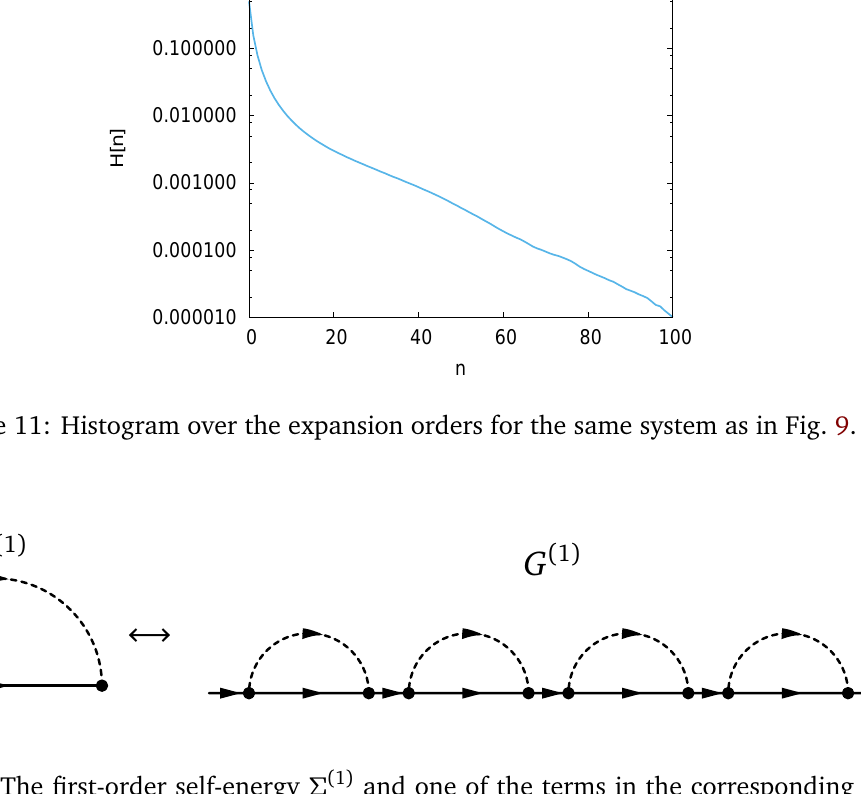
Figure 12: The first-order self-energy Σ ( 1 ) and one of the terms in the corresponding Green function G ( 1 )